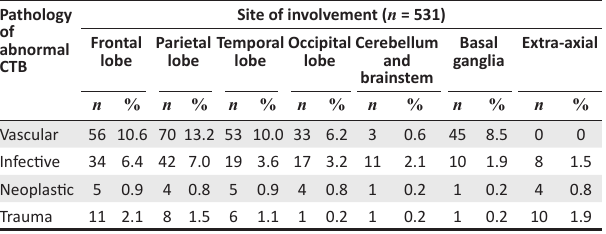
TABLE 3 : CTB abnormality in patients with new-onset seizures characterised by site of involvement. Pathology